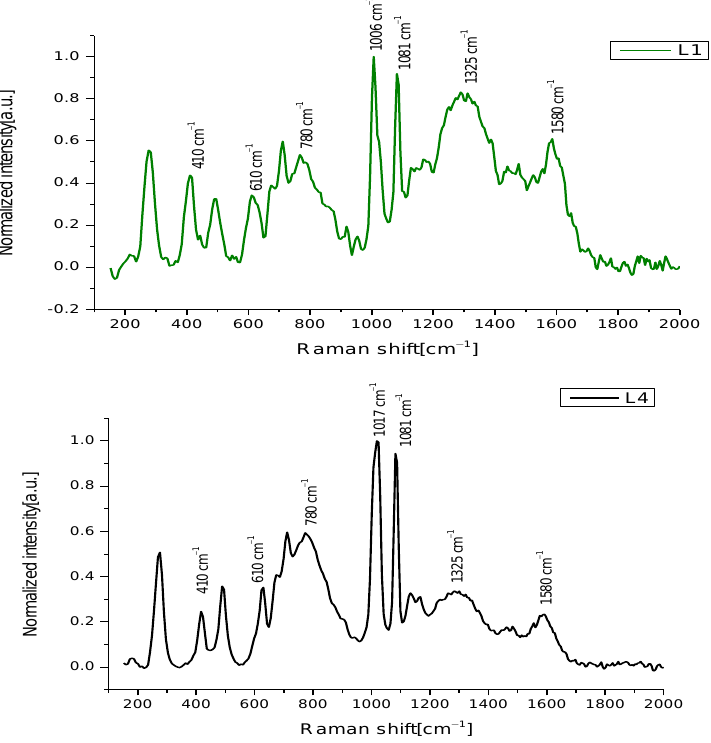
Figure 3. Raman spectra of different painted lines of fresco fragments.